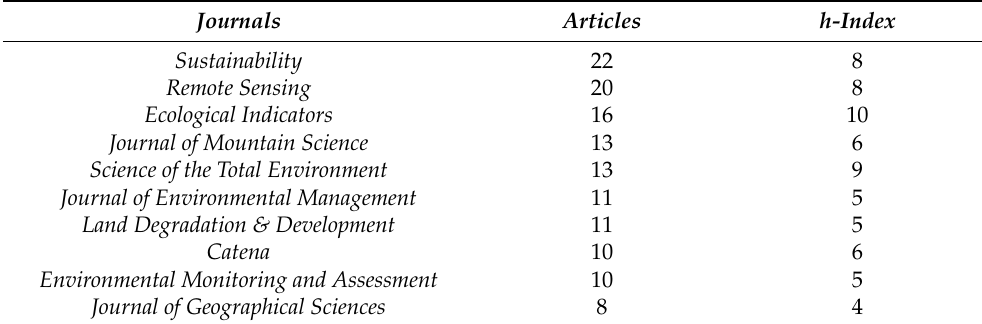
Table 1. Number of papers issued by the top ten journals and corresponding h-indices considering the ecological and environmental effects of land use and cover changes (LUCC) on the Qinghai – Tibetan Plateau (QTP) from 1995 to 2022.